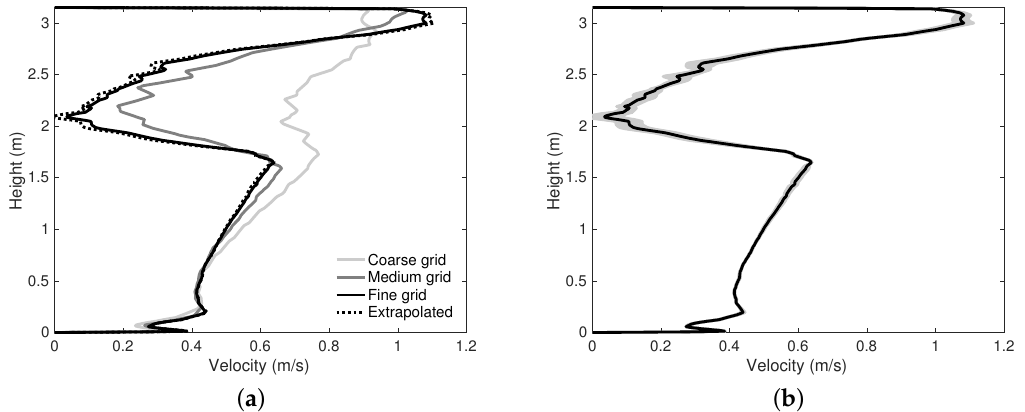
Figure 3. Velocity profiles along L1 for ( a ) all the different grids and ( b ) the fine grid with error bands. RSM is used as turbulence